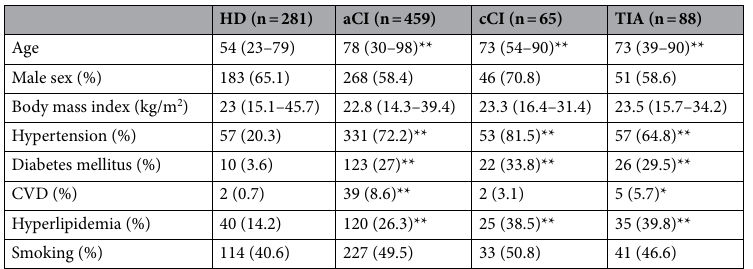
Table 1. Baseline characteristics of the participants. Data are medians (interquartile range) for numerical data and n (%) for categorical data. CVD cardiovascular disease, HD healthy donor, aCI acute cerebral infarction, cCI chronic cerebral infarction, TIA transient ischemic attack. * p < 0.01, versus HD; ** p < 0.001, versus HD. The Kruskal–Wallis test was performed for continuous variables and the chi-square test was used for categorical